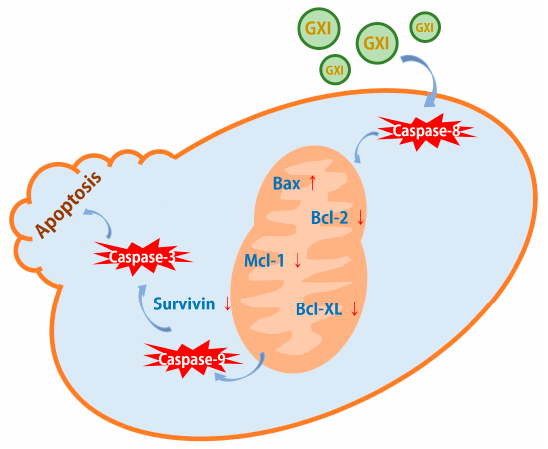
Figure 5. GXI-induced apoptosis via the mitochondrial pathway.